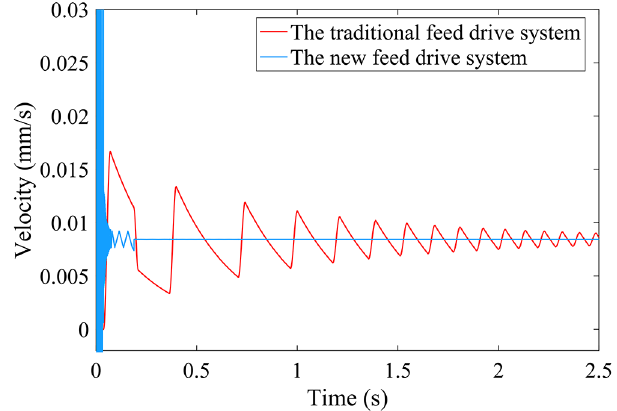
Fig. 4. Comparison of the velocity fl uctuation between tradi- tional and new FDS.